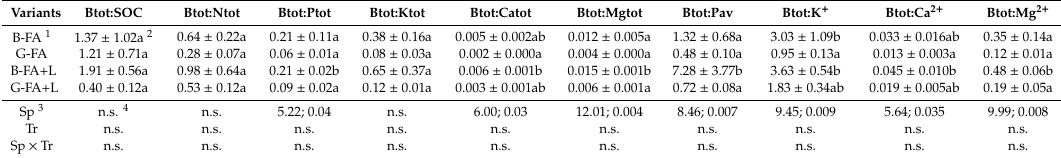
Table 5. The ratio of the carbon and nutrient resources in the total biomass (B tot ) to that in the soils (0–30